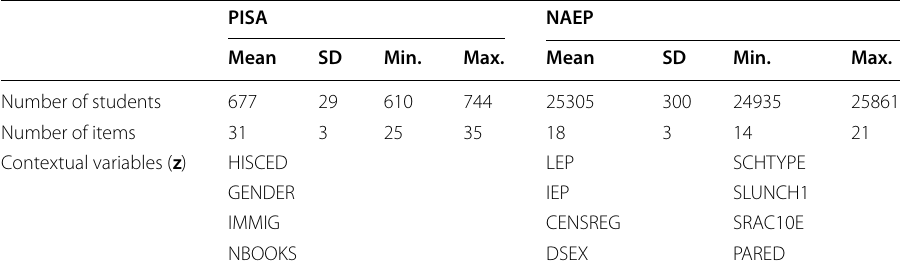
Table 1 Distribution of sample size and number of items per timing section, and the list of contextual